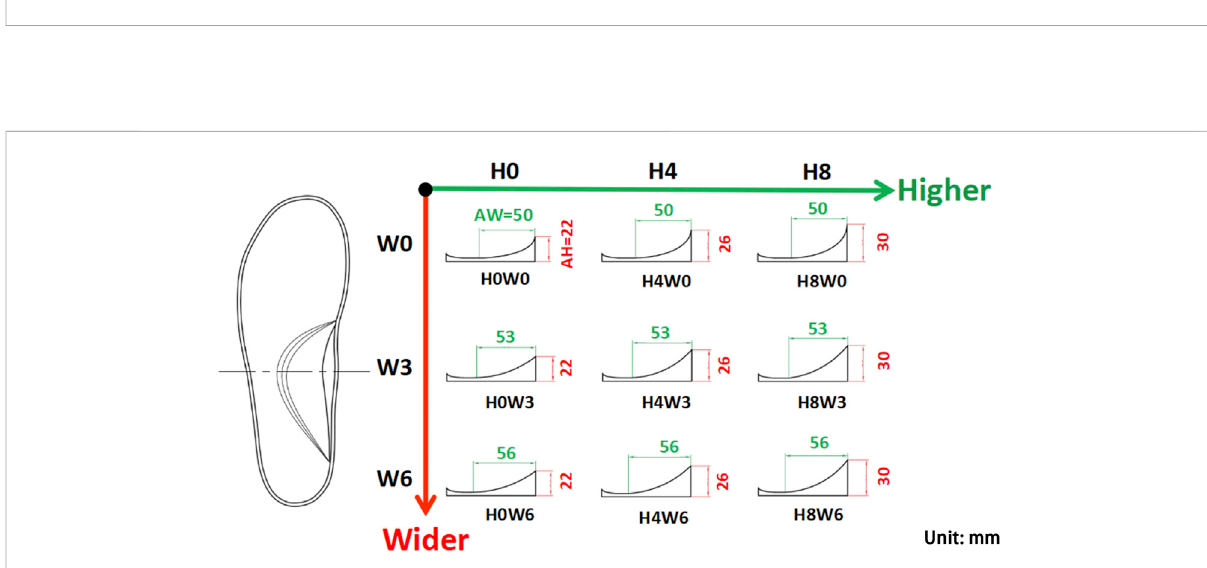
FIGURE 2 Nine variations of the arch support with three doses in the arch support height (AH: H0, H4, and H8 in mm) and three doses in the arch support width (AW: W0, W3, and W6 in mm).